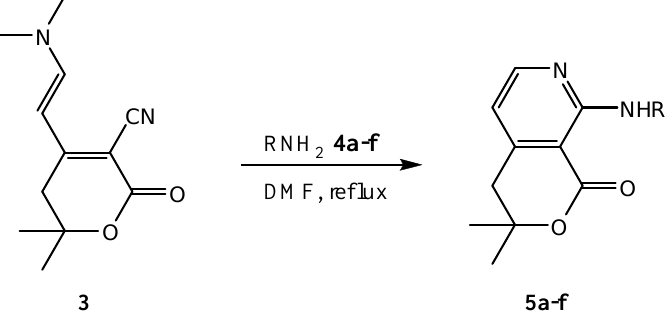
Figure 3. Synthesis of 2-aminopyridines 5a-f from enaminolactone nitrile 3. Table 1. Synthesis of 2-aminopyridine lactones.